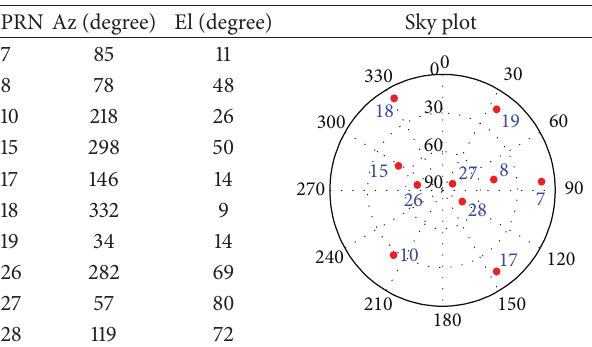
Table 2: Satellite visibility during test: simulator